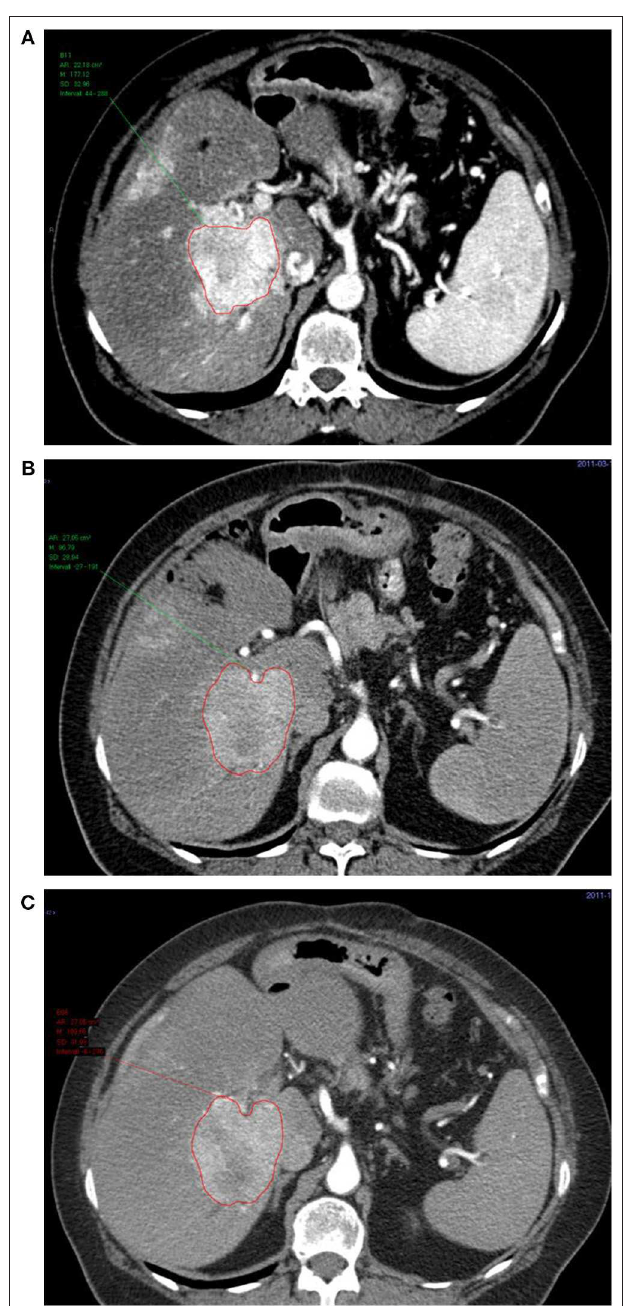
FIGURE 2 | Transversal contrast-enhanced CT images in the arterial phase of a liver metastasis at baseline (A) , before the 3rd cycle of treatment (B), and at follow-up (C) .